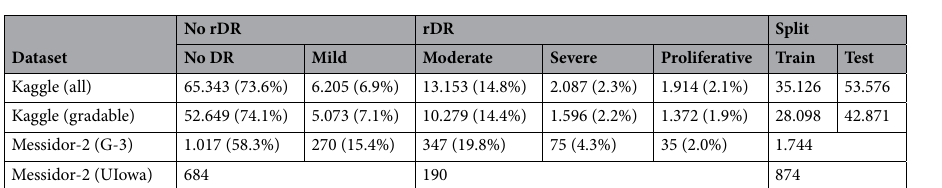
Table 1. Distribution of the 5 DR grades in the images of the Kaggle-EyePACS and Messidor-2 datasets. Available grades for Kaggle-EyePACS have been provided by a single expert. For Messidor-2 the publicly available grades include an adjudication by a panel of 3 experts (G-3) and a per-patient diagnosis of rDR versus no rDR (UIowa).